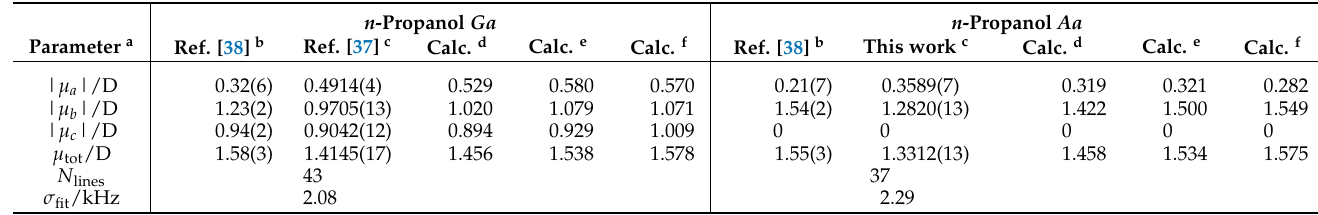
Table 2. Electric dipole moments of the Ga and Aa conformers of n -propanol.